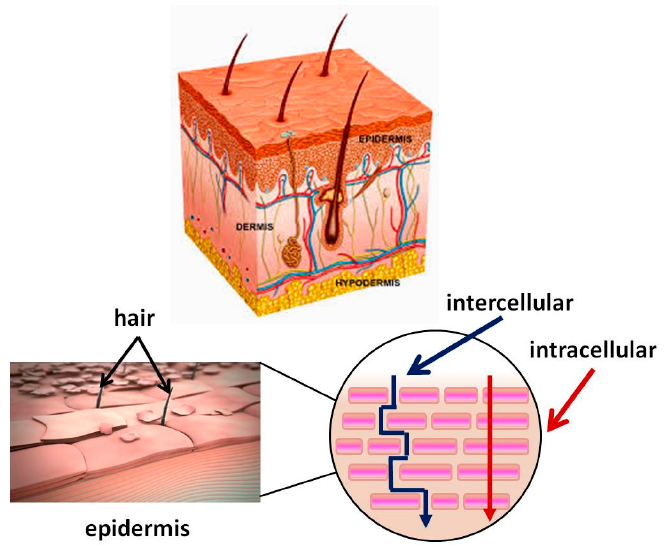
Figure 1. Skin structure. Mechanism of passage through the skin of biologically active substance BAS. 209